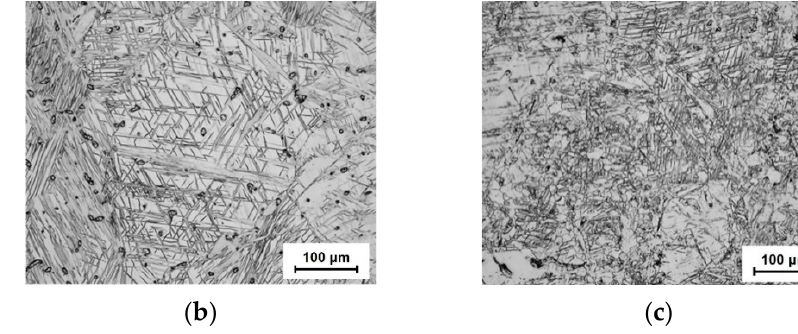
Figure 3. Microstructures of AZ31 alloy. Each figure shows the condition under ( a ) as-received and after rolling with the reduction rate of ( b ) 10% and ( c ) 50%. after rolling with the reduction rate of ( b ) 10% and ( c )